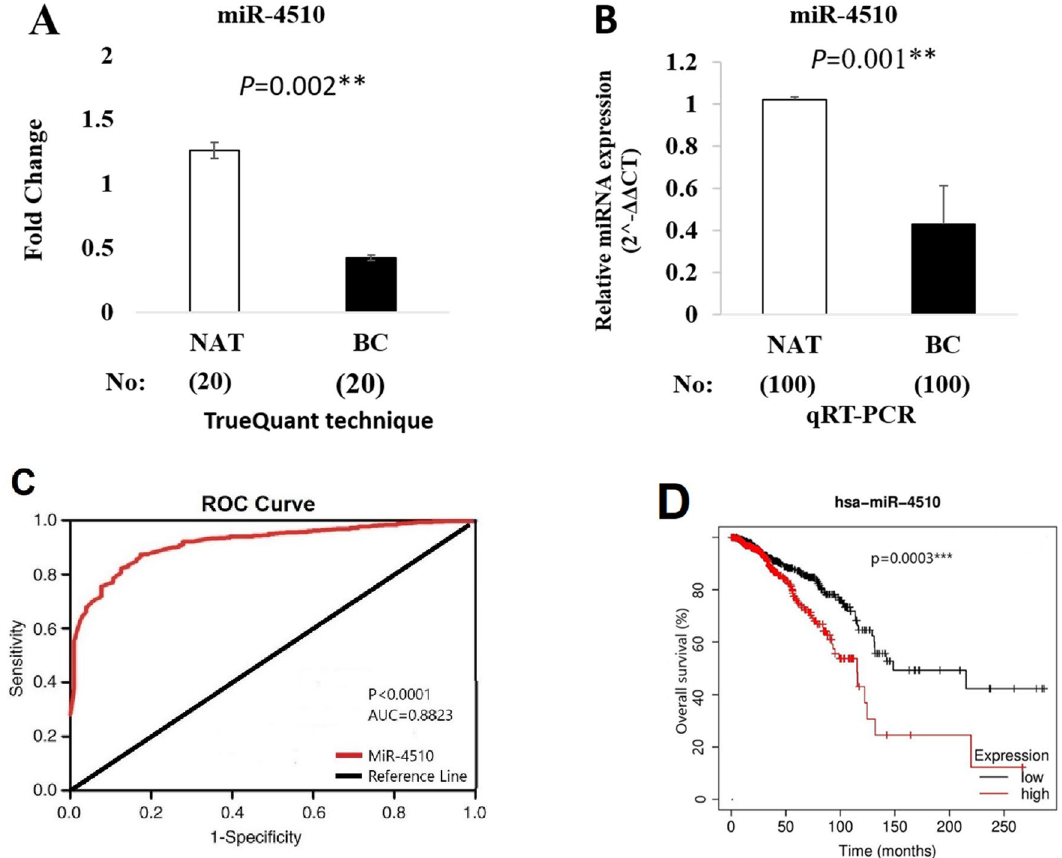
Figure 2. ( A ) Differential expression of miR-4510 in BC was compared with NAT using the MACE-seq method. ( B ) Differential expression of miR-4510 in BC was compared with NAT using the RT-qPCR method. ( C ) ROC curves for miR-4510 based on the RT-qPCR data derived from the breast cancer and normal tissues. The diagram designed the sensitivity (true positive rate) against 1—specificity (false-positive rate) over all possible ΔCT values. The AUC number show that the two classes could be differentiated by expression analysis of the biomarker. ( D ) K-M analysis of an association between miR-4510 expression and patient overall